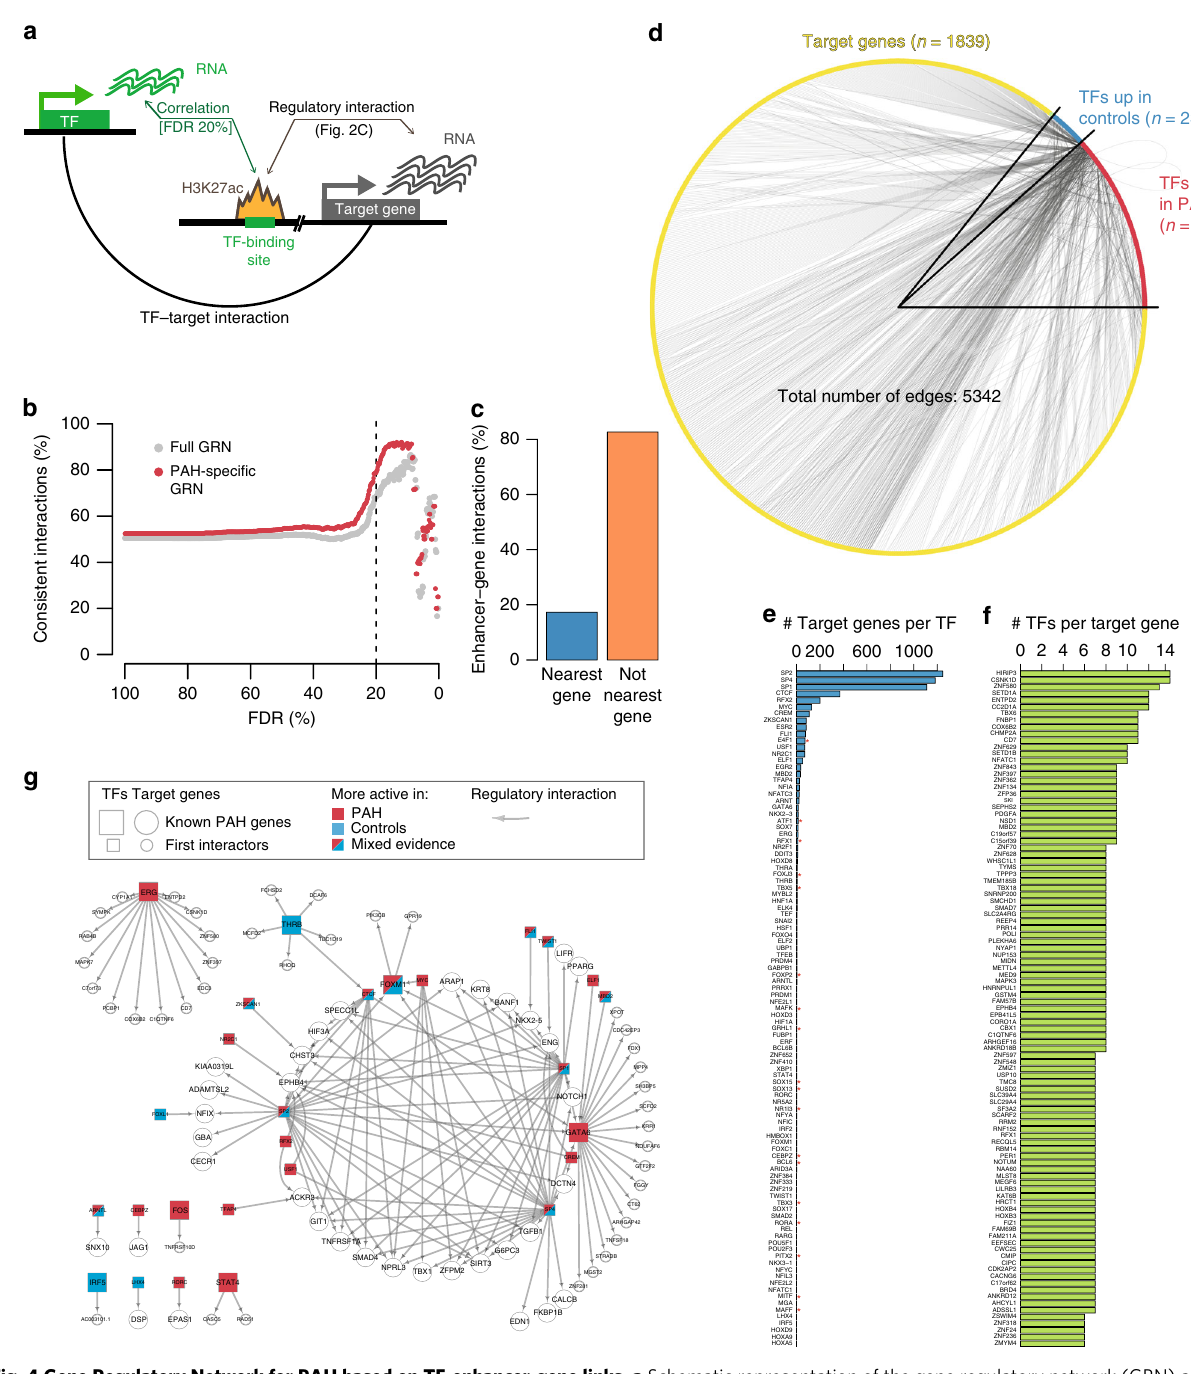
Fig. 4 Gene Regulatory Network for PAH based on TF-enhancer-gene links. a Schematic representation of the gene regulatory network (GRN) approach. b Fraction of consistent interactions de fi ned as regulatory interactions where the TF activity varies in the same direction as the H3K27ac signal at the putative target peak. The consistency increased considerably around the 20% FDR threshold (see Methods). c Percentage of regulatory interactions mediated by enhancers that are connected to the nearest transcription start site (TSS; blue, n = 1289) vs other TSS (orange, n = 6153). d GRN in PAH. Nodes represent TFs (square) and target genes (circle) that are within chromatin regulatory domains (CRDs). TFs more active in PAH (red), TFs more active in controls (blue), target genes more active in PAH (orange) and target genes more active in control (green). The color of the edges represents a positive (green) and negative (red) correlation for TF expression and H3K27ac signal at the promoter of the target gene. TFs with more than 100 connections were removed to improve clarity of the network visualization. The network is provided in Supplementary Data 5. e Ranked TFs by their number of interactions in the PAH genetic regulatory network. f Ranked target genes by their number of interactions in the PAH genetic regulatory network, to make clear the plot only the top 100 target genes are represented. g Detailed sub-network of the PAH-GRN of known genes associated with PAH (large nodes) and their fi rst interactors (small